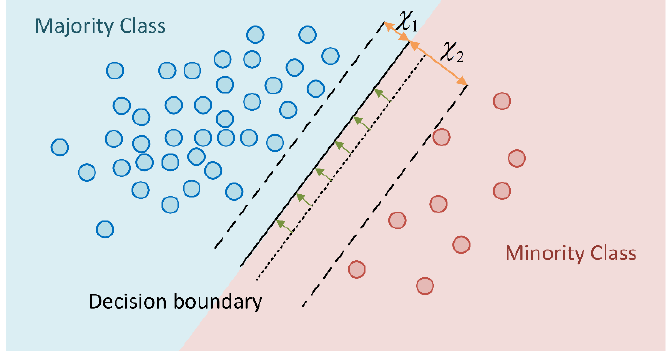
Figure 5. Adjusting class margin to reduce test errors.